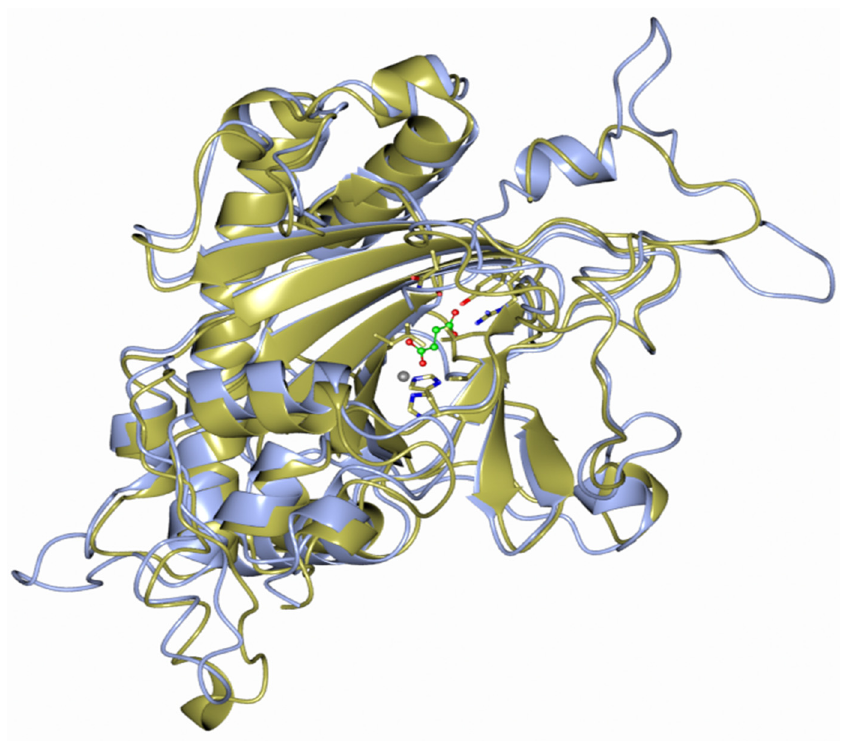
Figure 3. The DMR6 3D protein model created using Modeller software and visualized using Ccp4mg software. The C. mollissima (Cm) DMR6 (blue) protein and A. thaliana (At) DMR6 (yellow) protein are shown.